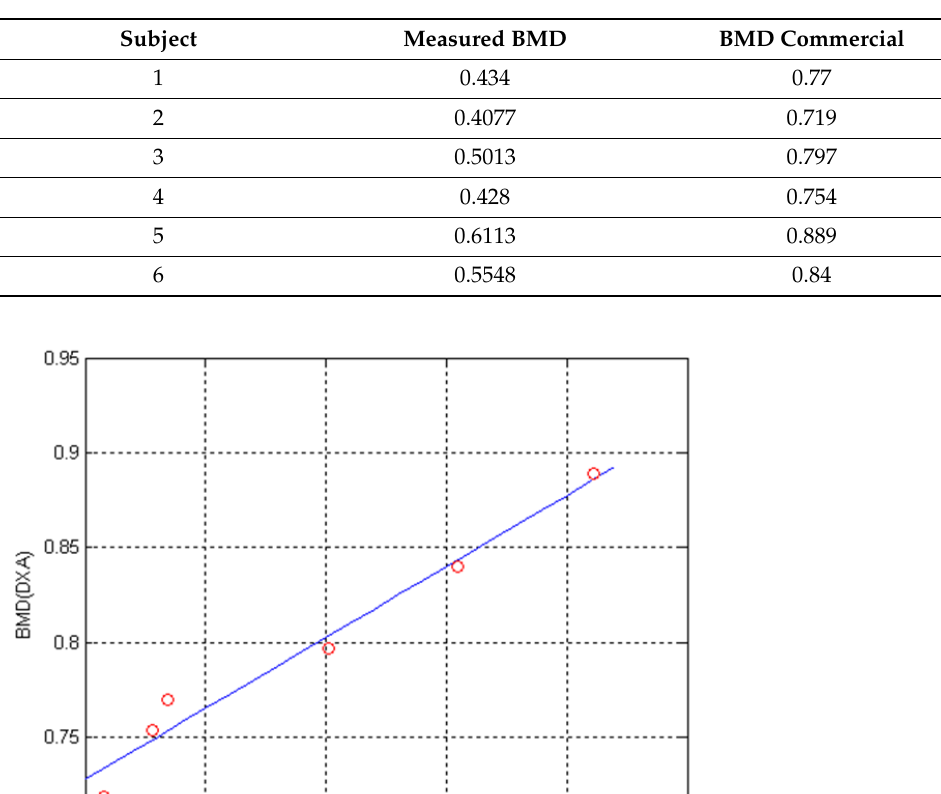
Table 5. Comparison between the BMD measured from proposed bone mineral density system and that measurd from commercial bone mineral density system.